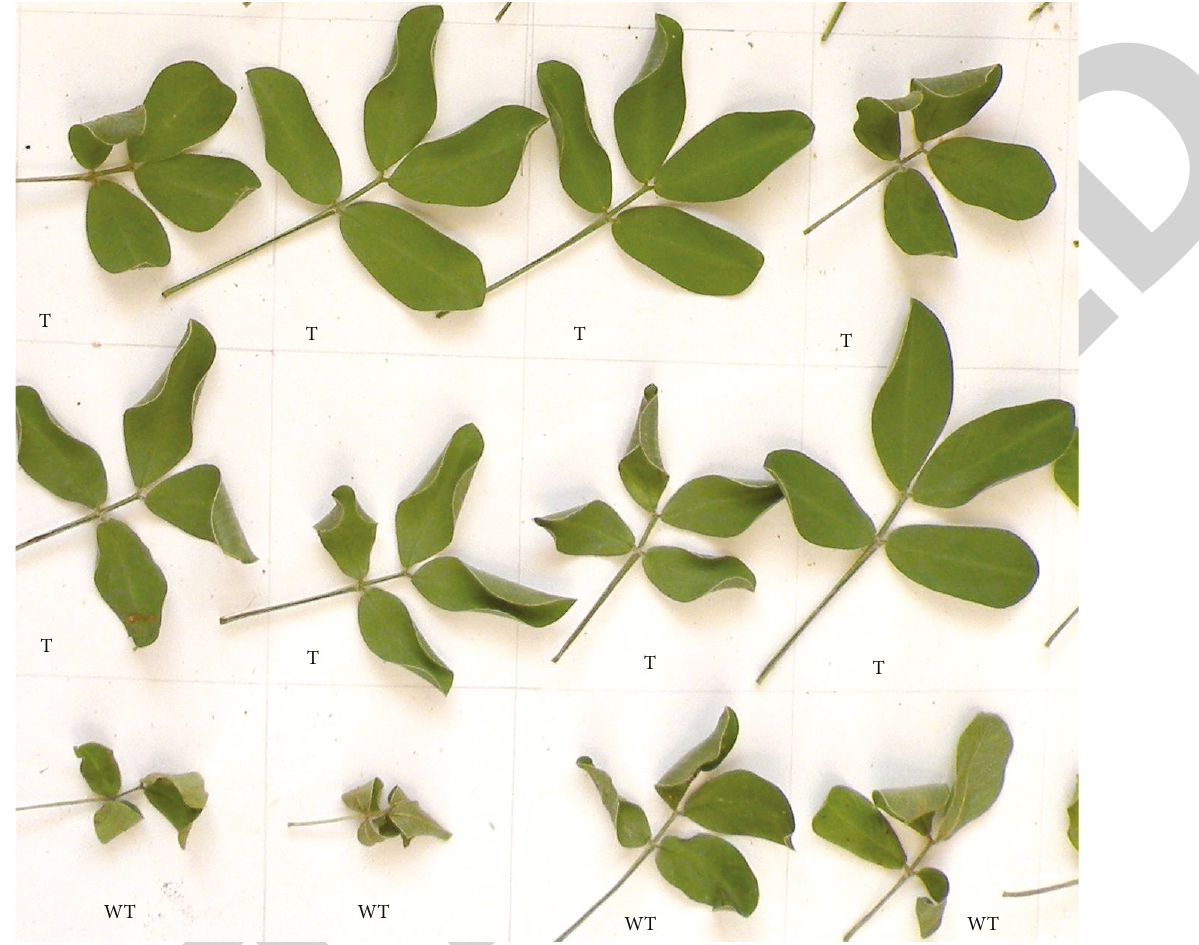
Figure 4: Representative picture of excised-leaf water loss assay where detached leaves of transgenic (T) plants showed less water loss in a given time-span over wild-type (WT)